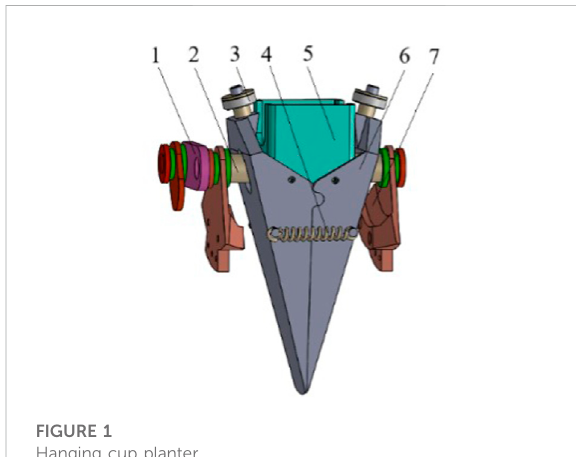
FIGURE 1 Hanging cup planter.